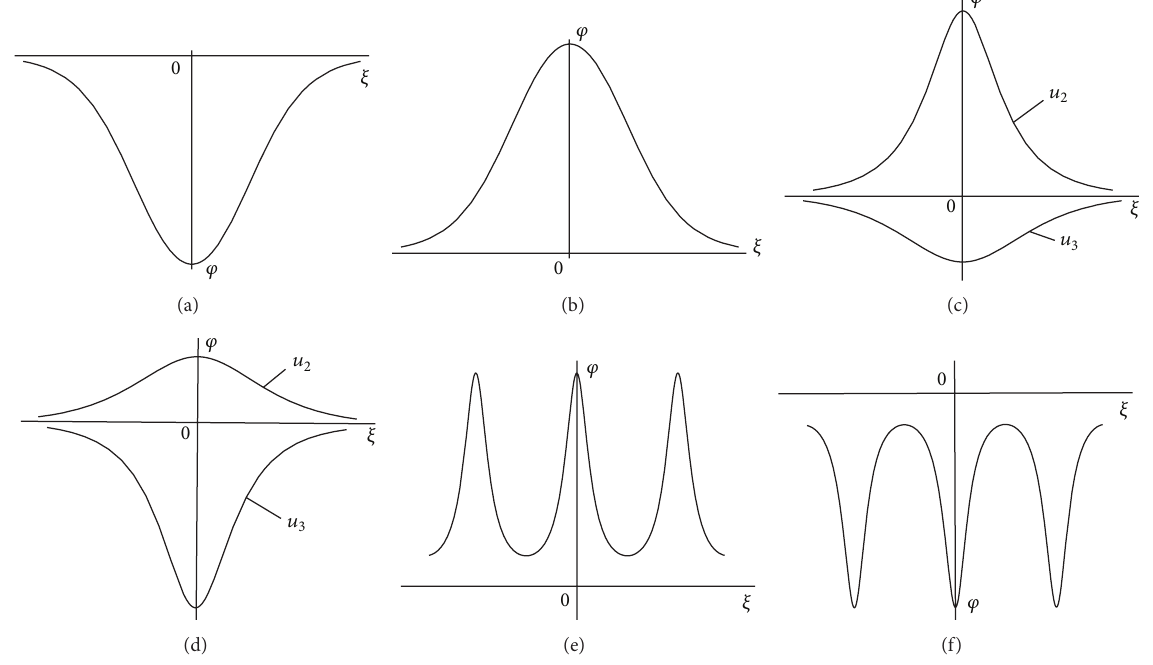
Figure 4: Smooth solitary wave and periodic wave